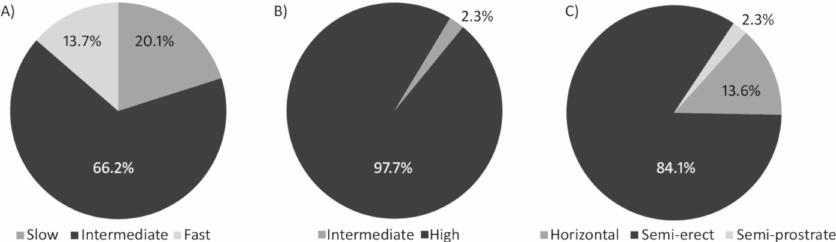
Figure 1. Percentage of populations included in the di ff erent categories described for the qualitative categorical descriptors ( n = 44). ( A ) Plant growth rate with three categories ranging from slow rate ( < 4 in the scale) to fast rate ( > 6 in the scale). ( B ) Plant adaptation with two categories: intermediate (5 in the scale) and high adaptation ( > 6 in the scale). ( C ) Leaf growth attitude with three defined categories: semi-prostrate, horizontal, and semi-erect. For more details refer to Table 1.